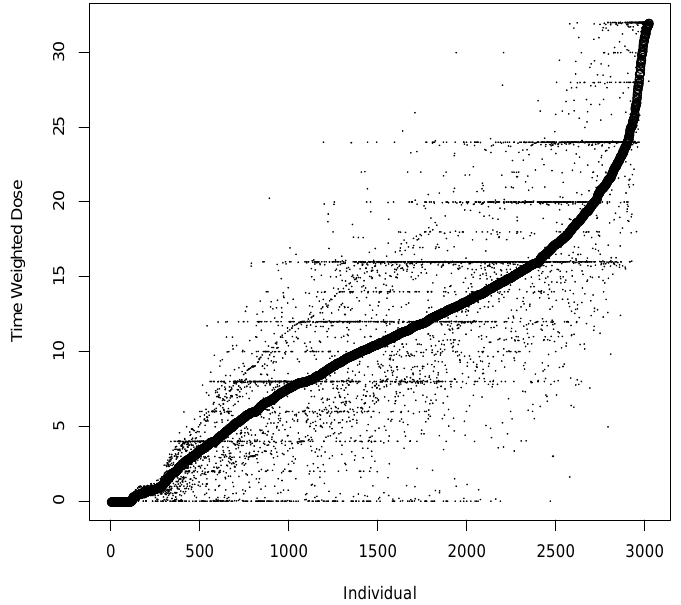
Figure 1. Mean Time Weighted Dose from 0 to 32 mg. Dots are participant 25th and 75th quantiles.